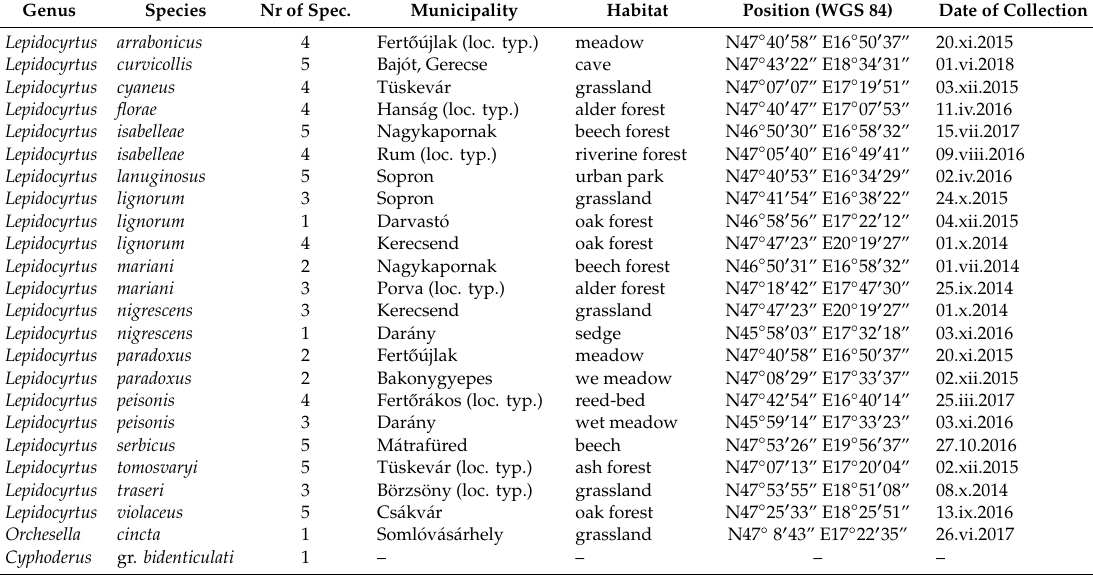
loc. typ.: Specimens collected from the species’ type